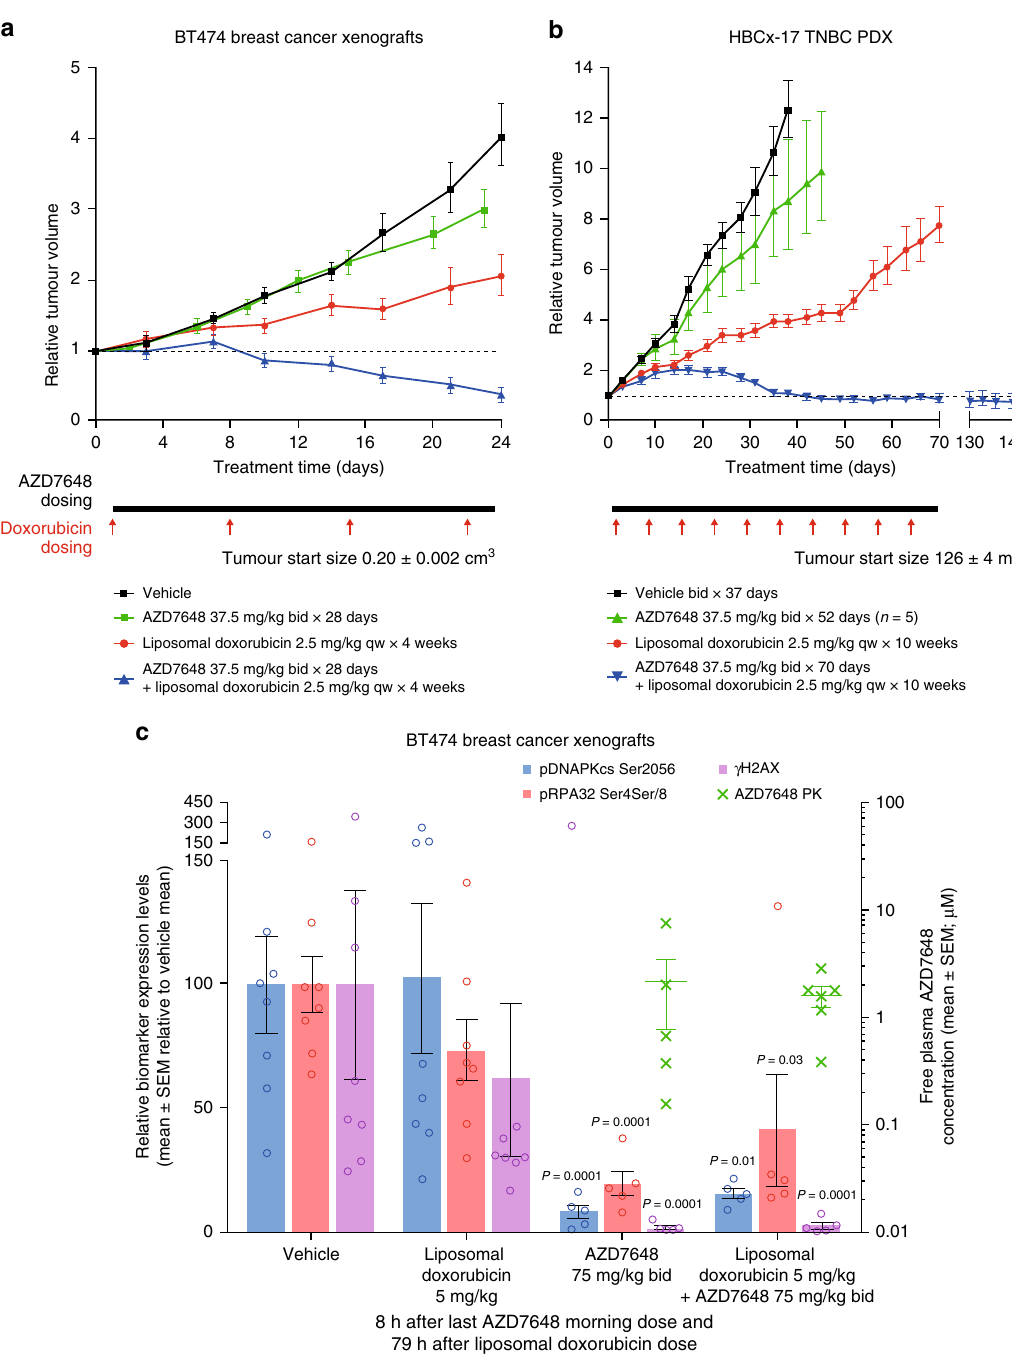
Fig. 4 AZD7648 and liposomal doxorubicin synergize to inhibit tumour growth in vivo. a BT474. AZD7648 induces tumour regression in combination with liposomal doxorubicin in BT474 breast cancer xenografts (nude mice, vehicle and AZD7648 n = 12, liposomal doxorubicin n = 9, combination n = 11, geometric mean ± SEM). b AZD7648 induces tumour stasis in combination with liposomal doxorubicin in HBCx-17 TNBC PDX (nude mice, n = 10, geometric mean ± SEM). For a and b , corresponding mouse bodyweights and statistical analysis can be found in Supplementary Figs. 2C and 5A and Supplementary Table 3B. To assess tumour growth inhibition, a one-tailed, two-sample, t -test with unequal variances was used and for tumour regression, one-sample t -test analysis. c Pharmacokinetics of AZD7648 and pharmacodynamic modulation of DNA-PK biomarkers pDNA-PKcs Ser2056, pRPA32 Ser4/Ser8, and γ H2AX after dosing of AZD7648 and liposomal doxorubicin in BT474 xenografts. Mice were dosed once with liposomal doxorubicin and with AZD7648 for 3 days. Samples were then collected 8 h after a last morning dose of AZD7648 on the fourth day. Measured by western blotting (nude mice, vehicle and liposomal doxorubicin n = 8, AZD7648 and combination n = 5, mean ± SEM). Signi fi cance assessed with two-sided t -tests performed on log-transformed data assuming unequal